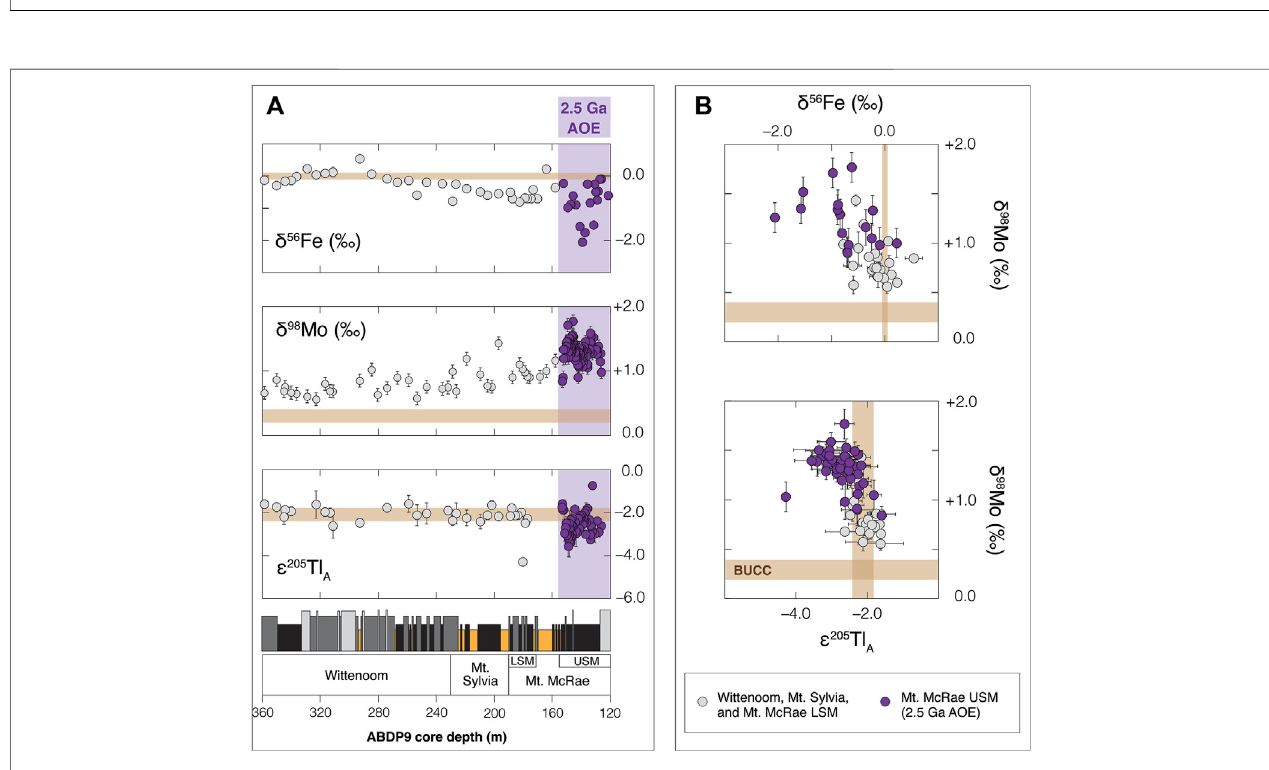
FIGURE 8 | (A) Updated Fe, Mo, and Tl isotope compilation from ABDP9 shales and (B) cross-plots of these same data. Brown rectangles in each panel signify bulk upper continental crust values for each isotope system (crustal δ 98 Mo value comes from Willbold and Elliott 2017; all other crustal value references can be found in the text). Iron isotope data are from Ostrander et al. (2022) and this study. Molybdenum isotope data are from Duan et al. (2010) and Ostrander et al. (2019; 2020). Thallium isotope data are from Ostrander et al. (2019) and this study. AOE = Archean Oxidation Event, BUCC = bulk upper continental crust, LSM = lower shale member, and USM = upper shale